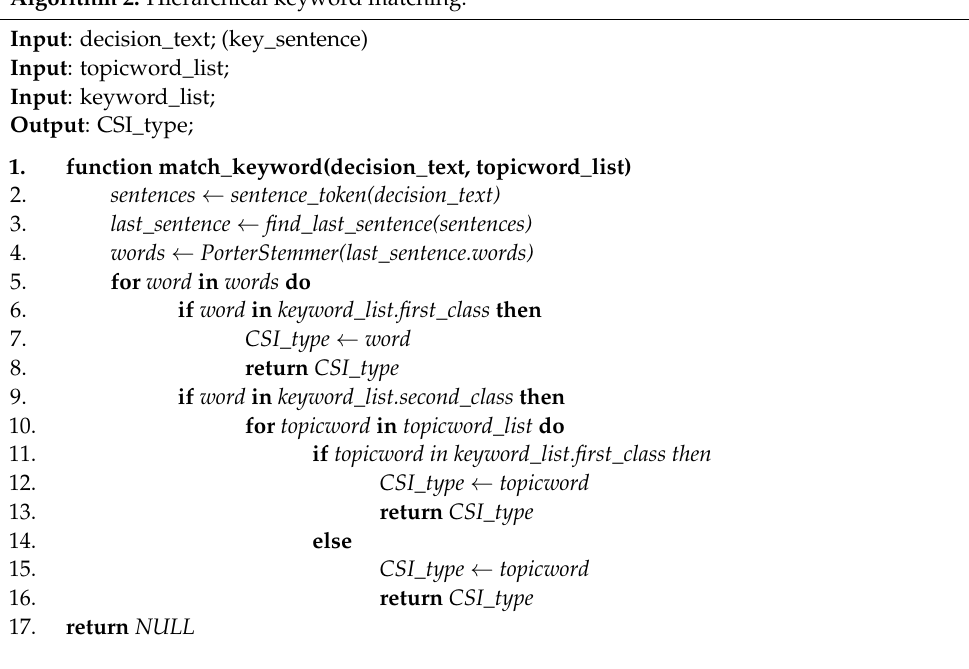
Algorithm 2. Hierarchical keyword matching.